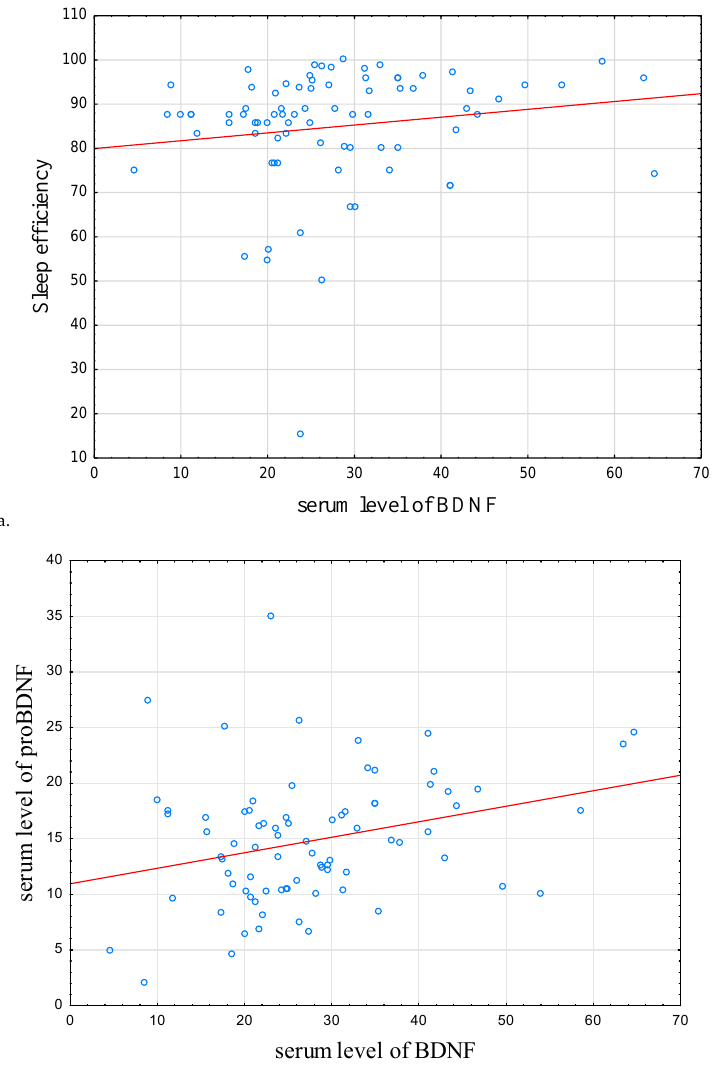
Figure 2. Correlations between sleep e ffi ciency, serum level of proBDNF, and BDNF. ( a ) Correlation between serum level of BDNF and sleep e ffi ciency. ( b ) Correlation between serum level of BDNF and proBDNF. In IBD subjects, there were positive correlations between sleep e ffi ciency, serum level of proBDNF, and serum level of BDNF (r = 0.234, p = 0.037 and r = 0.292, p = 0.009), respectively.